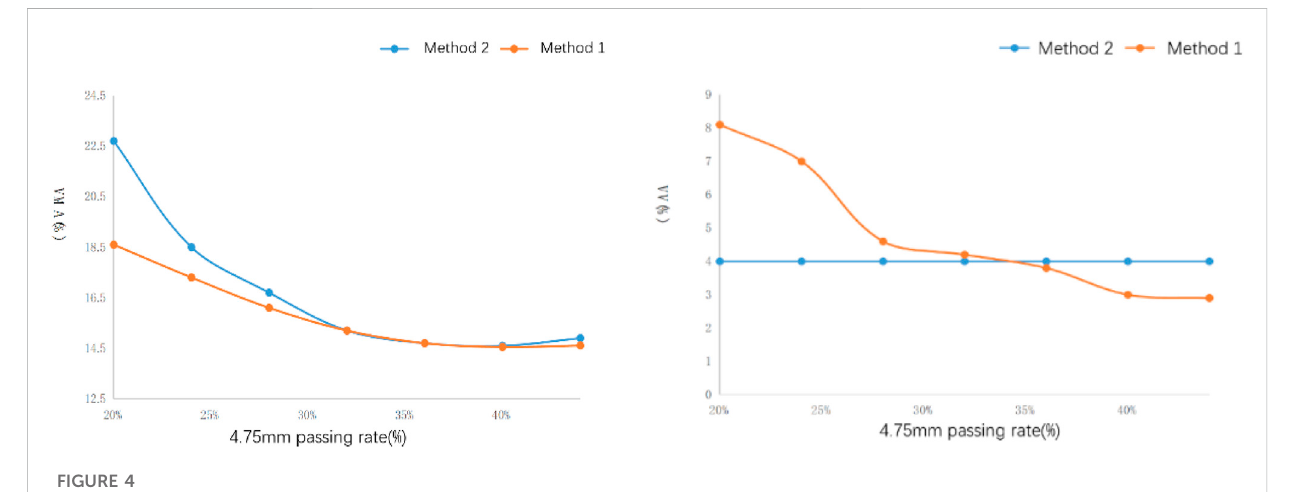
FIGURE 4 Relationships among the VMA, VV, and 4.75 mm passing rate, (A) VMA. (B) VV.